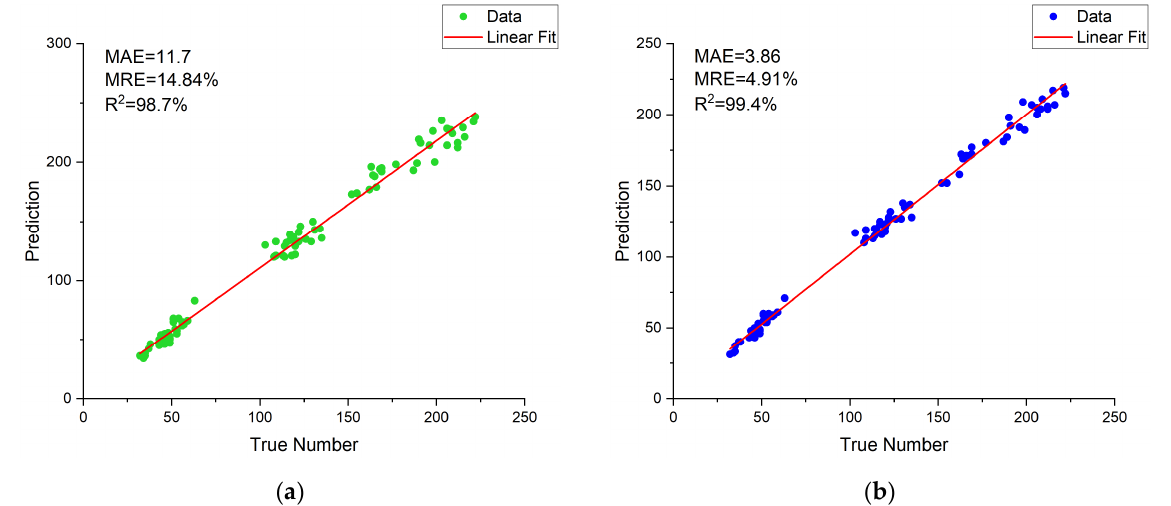
Figure 9. Analysis of seed counting results. ( a ) Correlation analysis between count results of common classification method and true value, ( b ) Correlation analysis between count results of improved classification method and true value.